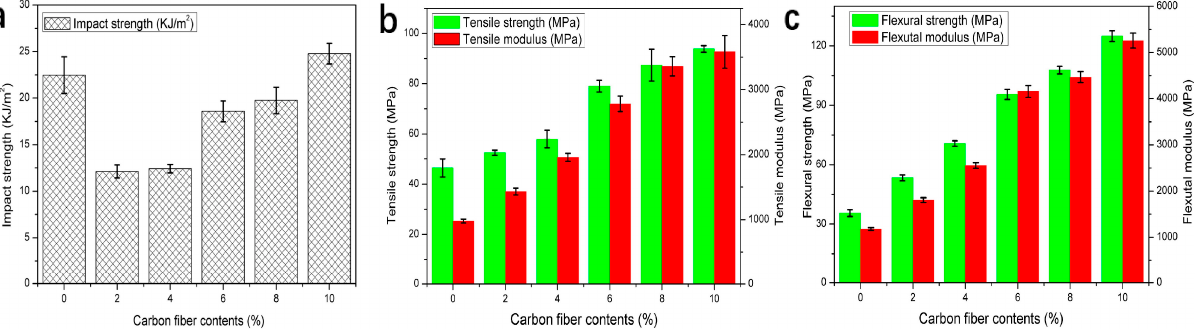
Figure 12. ( a ) Impact strength of PA12 and CF/PA12 composites; ( b ) tensile strength of PA12 and CF/PA12 composites; ( c ) flexural strength of PA12 and CF/PA12 composites (reproduced with permission from Reference [70], Copyright 2018 Elsevier).